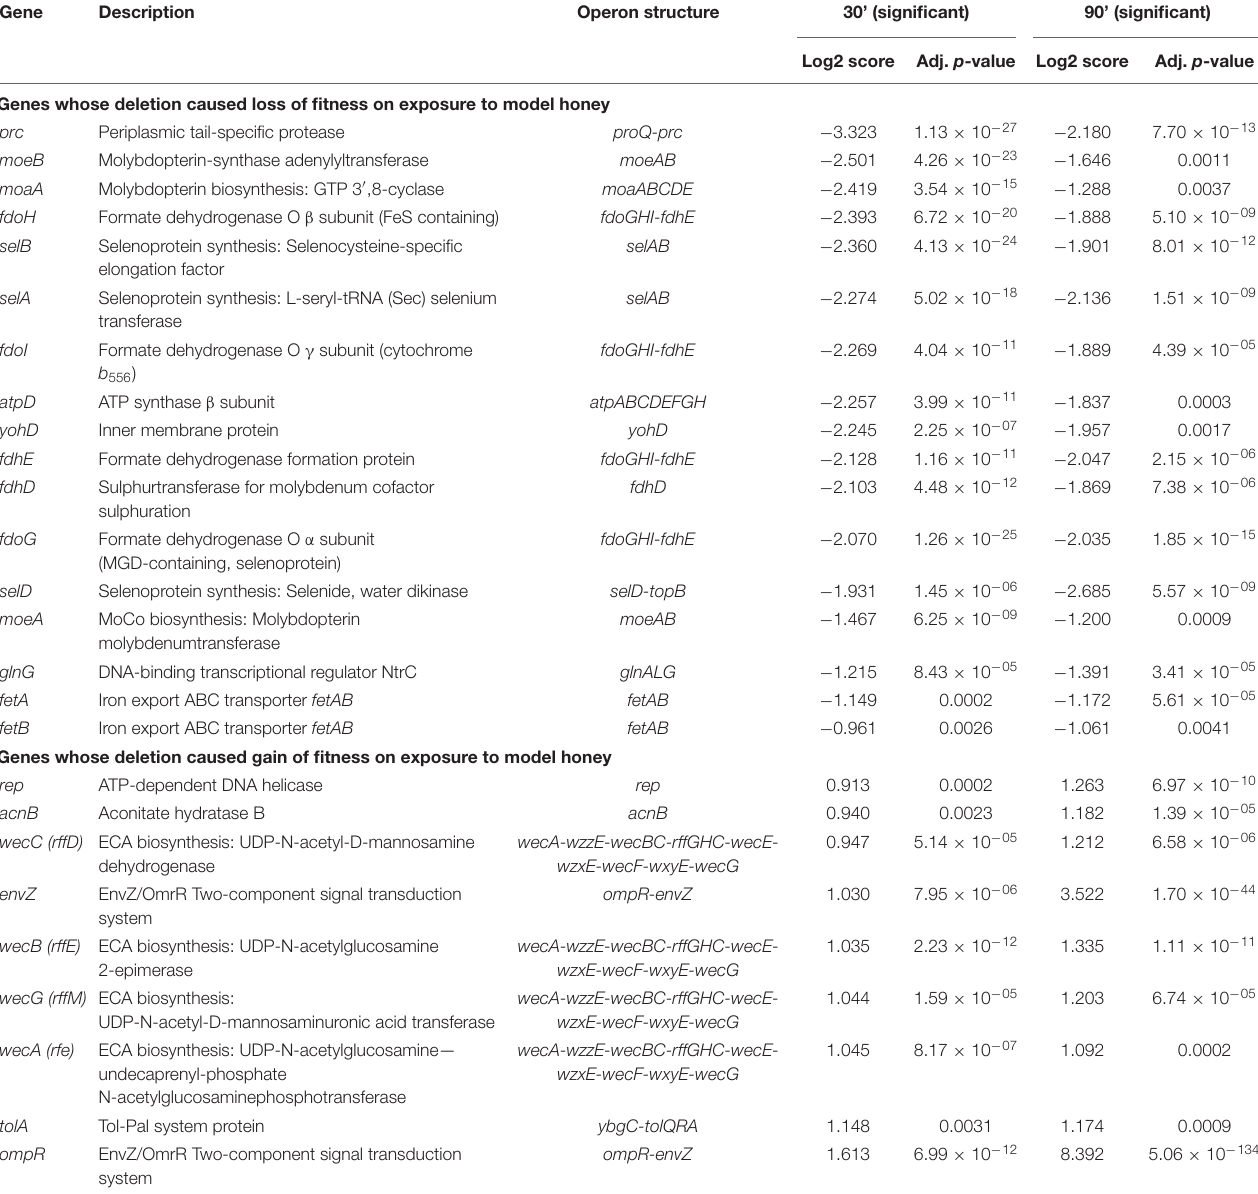
TABLE 2 | Genes that when mutated had a significant loss or gain of fitness at both 30 and 90 min following model honey challenge as identified by